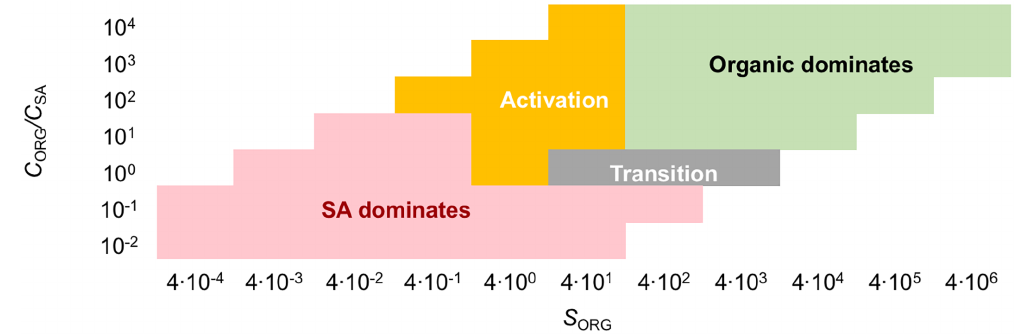
Figure 8. Growth mechanisms with different organic vapor saturation ratios ( S ORG ) and the ratios of organic vapor concentration ( C ORG ) to sulfuric acid concentration ( C SA ). In the red area, the growth is dominated by sulfuric acid, and in the green area by the organic vapor. In the yellow and gray areas, neither of them clearly dominates: in the yellow area, nano-Köhler-type activation, involving an increasing contribution of the organic vapor with increasing particle size, is observed, and in the gray area, there is a transition between these compounds without an activation.